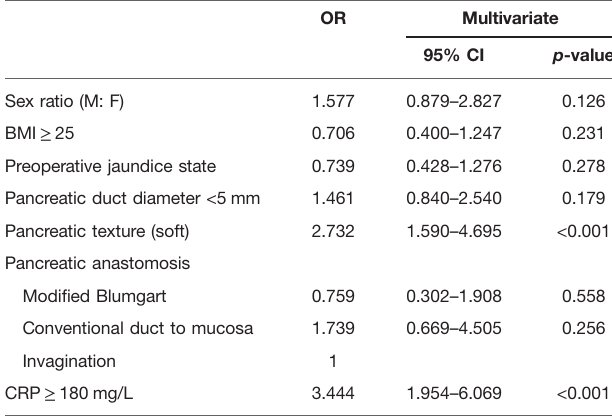
TABLE 5 | Multivariate analysis of grade B